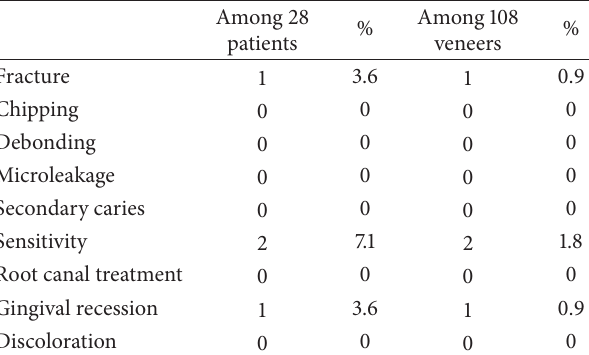
Table 5: Distribution of failures according to preparation design.